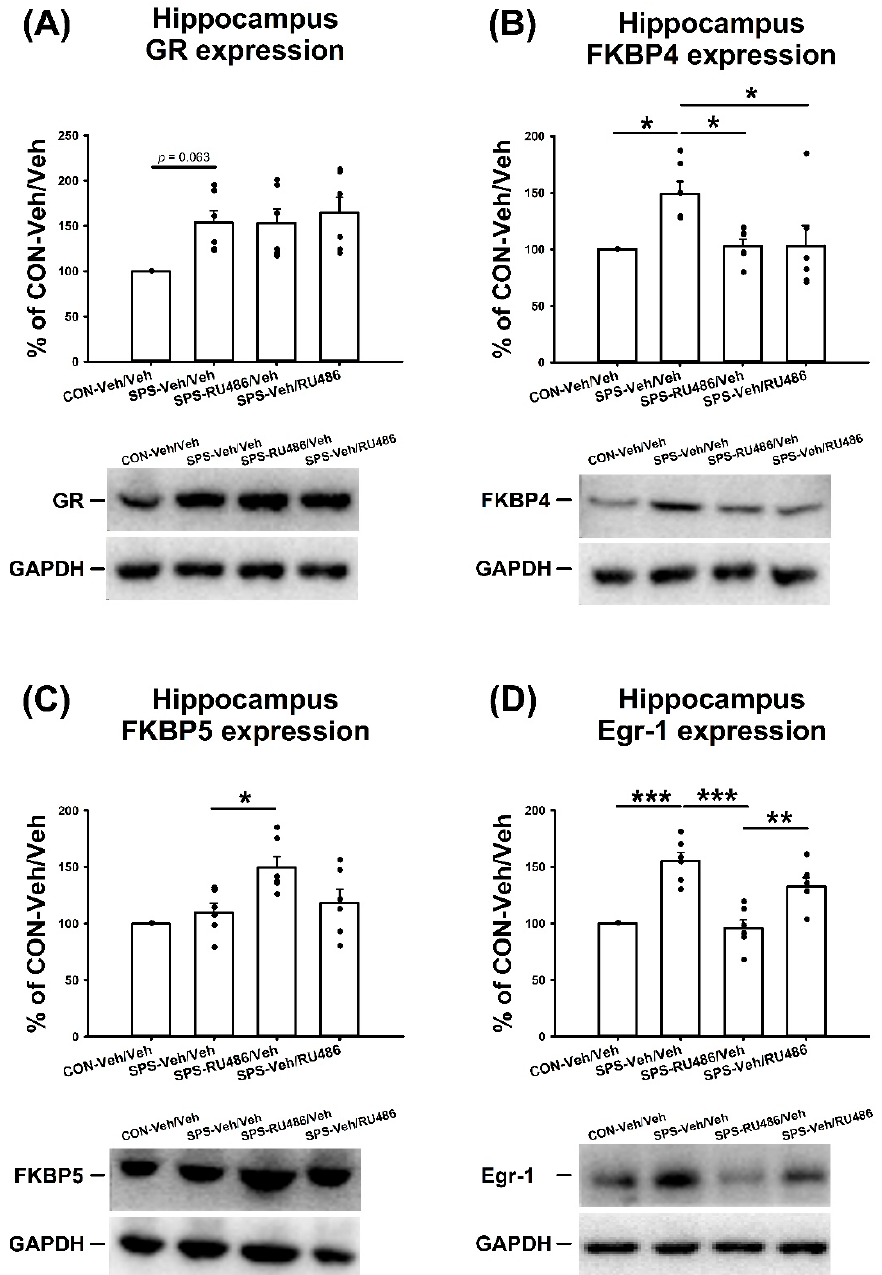
Figure 3. The expressions of the ( A ) GR, ( B ) FKBP4, ( C ) FKBP5, and ( D ) Egr ‐ 1 in the hippocampus after SPS paradigm and early/late RU486 intervention. The data represent the mean ± SEM. n = 6 for each group. Statistical analysis was employed with a one ‐ way ANOVA followed by Bonferroni post hoc testing. * p < 0.05; ** p < 0.01; *** p < 0.001.